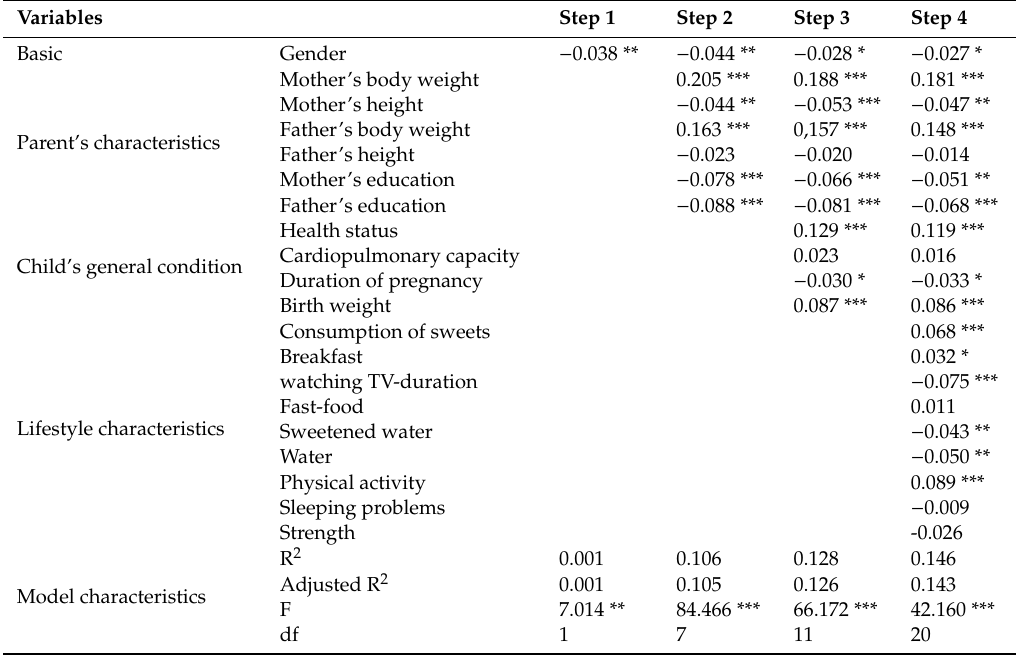
Table 3. Hierarchical regression analysis of children’s